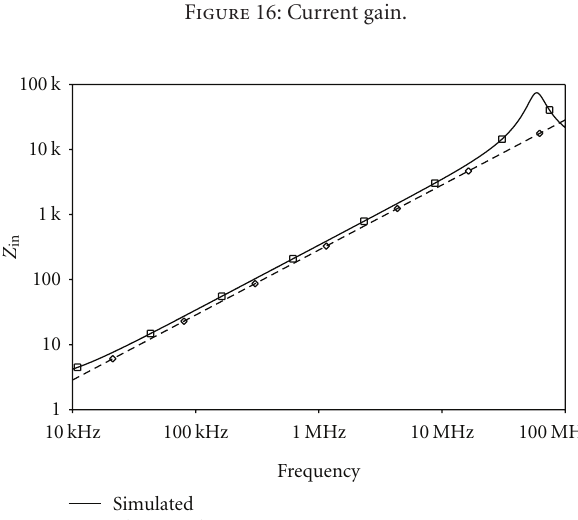
Figure 16: Current gain.